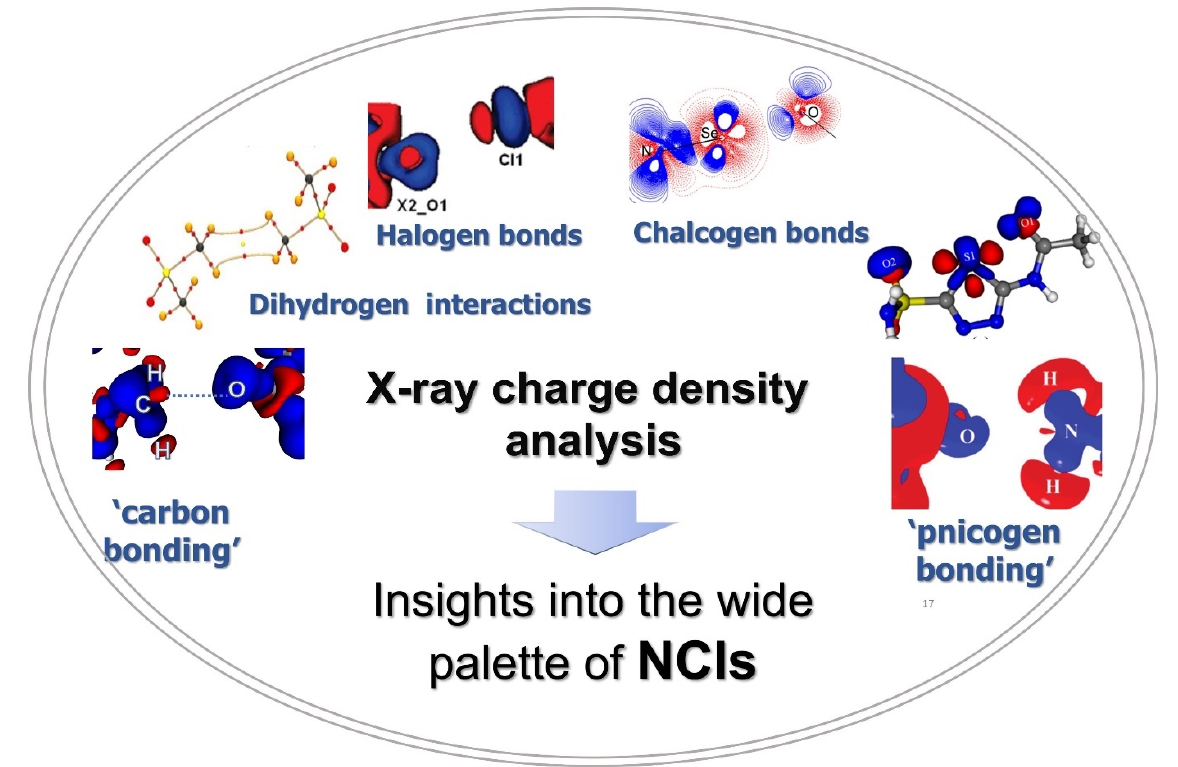
Figure 1. The wide palette of noncovalent interactions explored using X-ray charge density